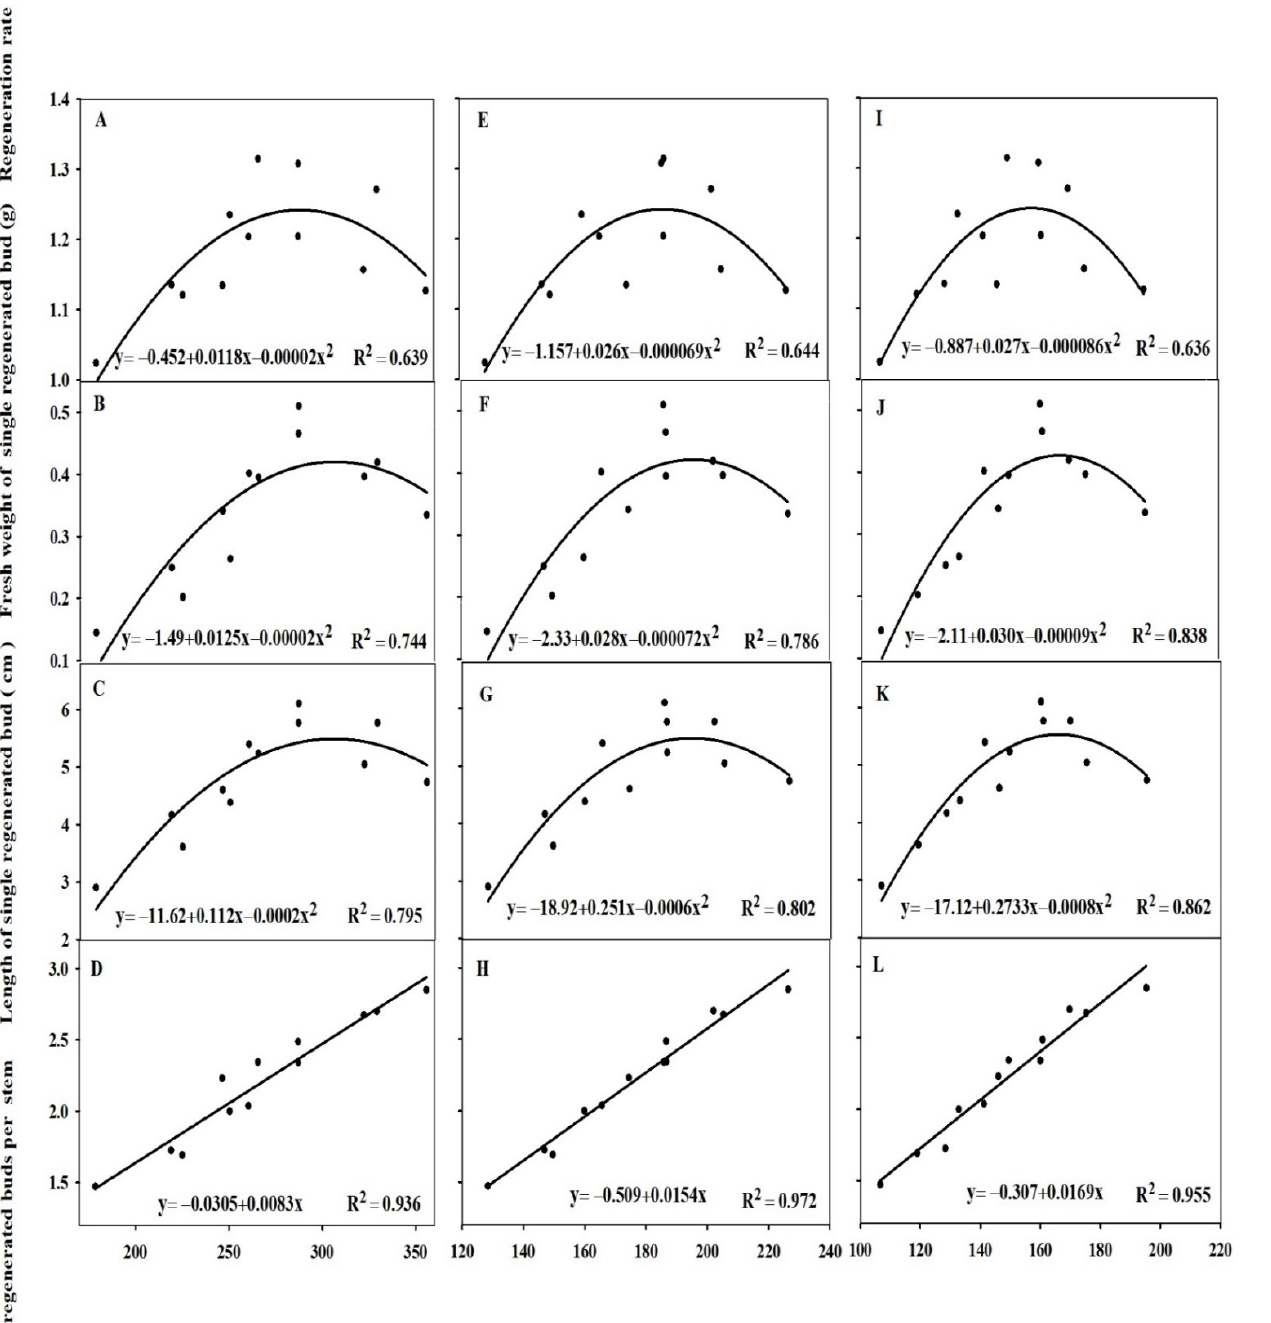
Figure 7. Relationships between NSC concentration of stem and leaf in the main crop and number ( D , H , L ), length ( C , G , K ), and fresh weight of regenerated buds ( B , F , J ) at maturity of main crop and regeneration rate ( A , E , I ). Note: HS, full heading stage of the main crop. DAH, days after heading of the main crop, MS, maturity stage of the main crop. ROA, root oxidation activity. The stubble NSC concentration was nonlinearly correlated with the regeneration rate. With increasing stubble NSC concentration, the regeneration rate first increased and then decreased (Figure